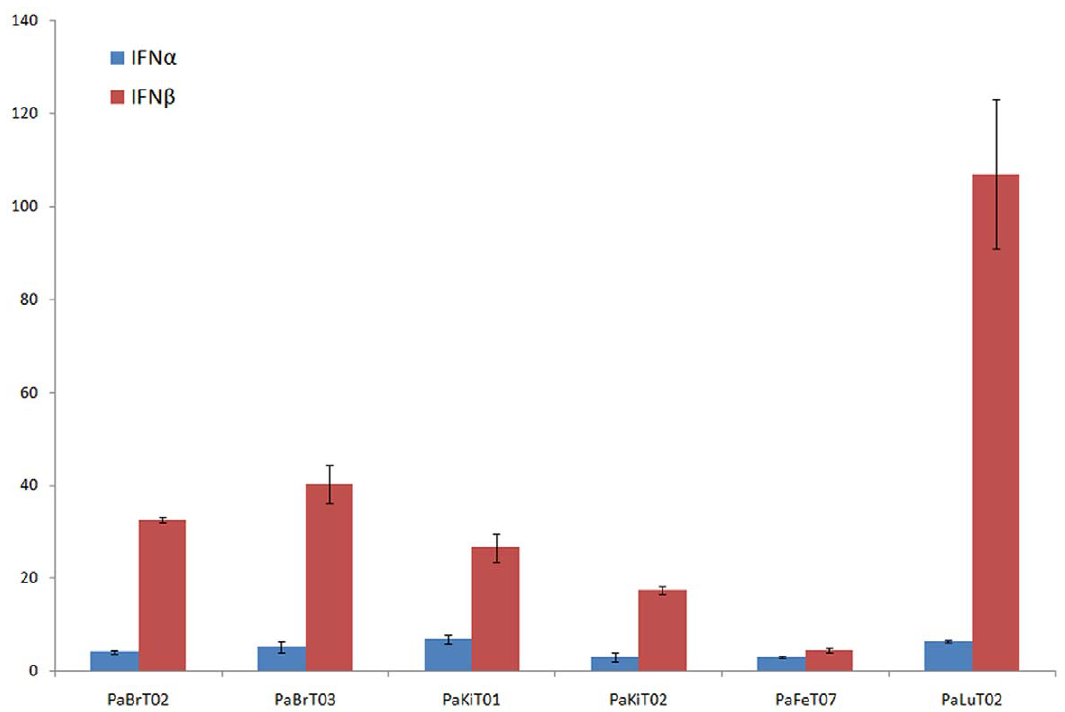
Figure 4. Induction of P.alecto interferon gene expression by poly I:C. Results shown are of fold increase in IFN- a and IFN- b transcript levels (measured by real-time PCR) after treatment of P. alecto cloned and SV40 Large T antigen immortalised brain, kidney and foetal cells with 10 m g/ml poly I:C over the basal level of IFN gene expression in mock treated cells. Error bars represent the standard deviation of the mean derived from duplicate